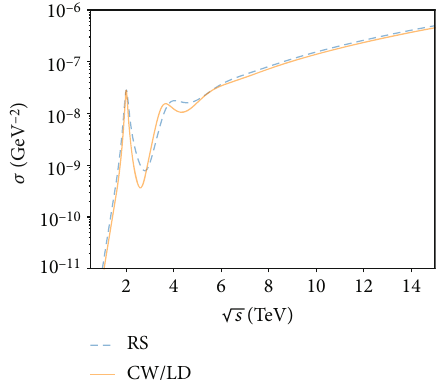
Figure 8: Comparison between the RS (dashed-blue line) and the CW (solid-orange line). For this plot, we choose λ = 1 : 5 and NP = ≈ 1334 GeV, and 1 , i.e., m = 2000 GeV, Λ = 2128 GeV, M 1 RS 5 CW ≈ 1131 k CW